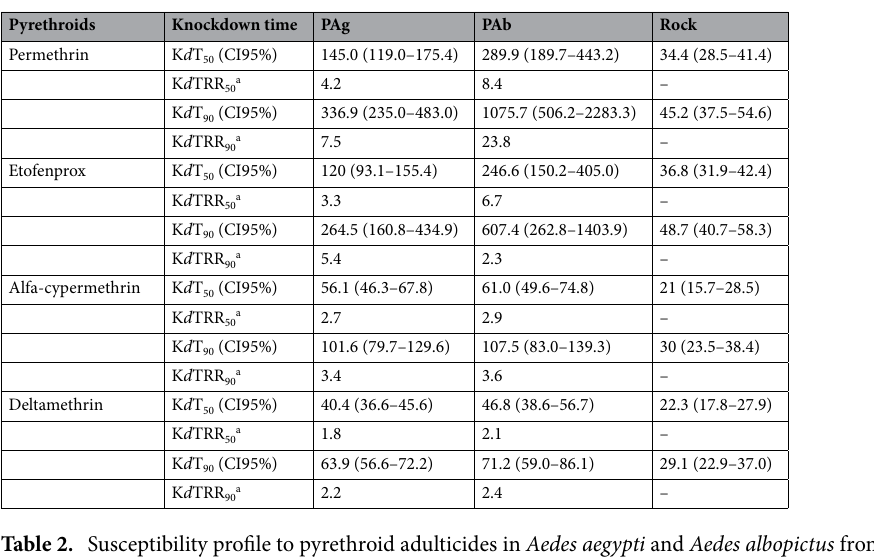
Table 2. Susceptibility profile to pyrethroid adulticides in Aedes aegypti and Aedes albopictus from Lahore, Pakistan. a Resistance ratios (RR) were calculated based on Ae. aegypti Rockefeller strain (Rock).